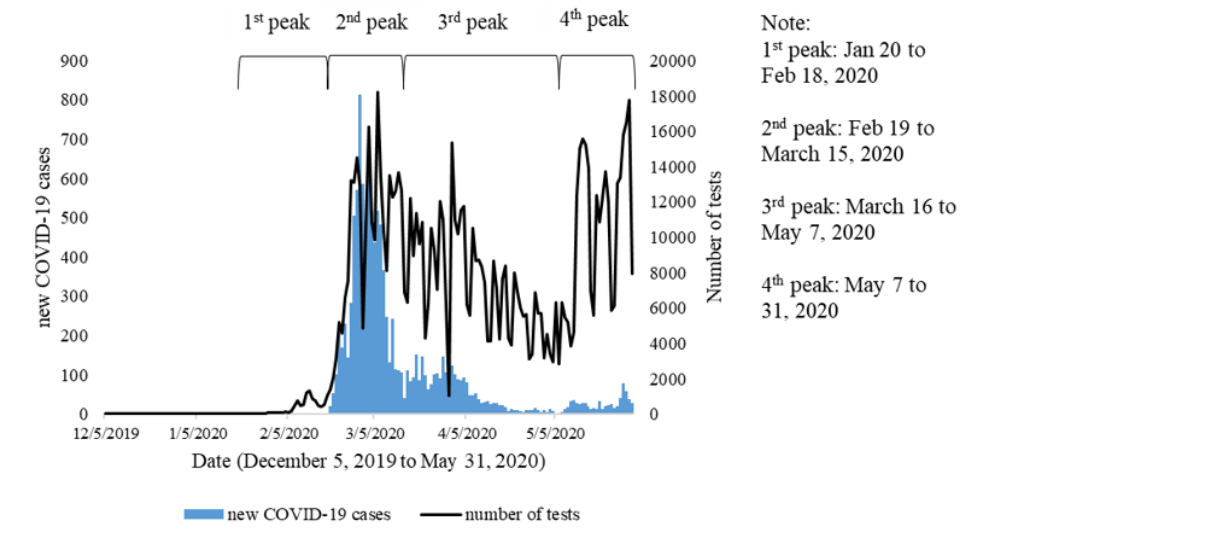
Figure 1. Time series of new COVID-19 cases and number of tests in South